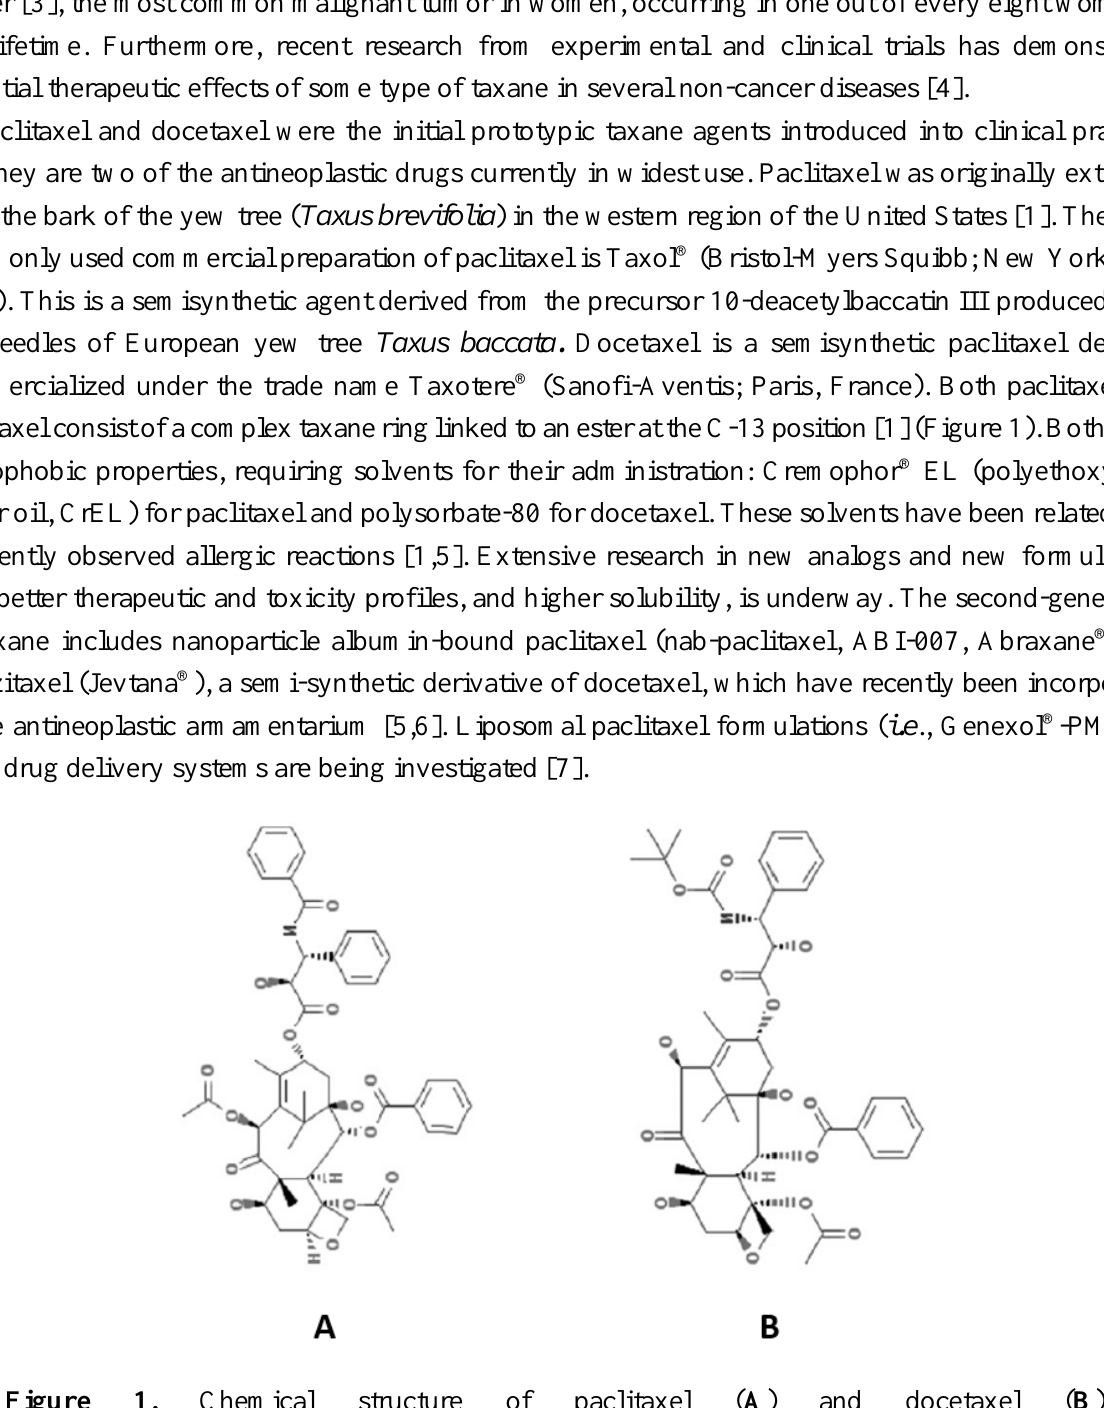
Figure 1. Chemical structure of paclitaxel ( A ) and docetaxel ( B